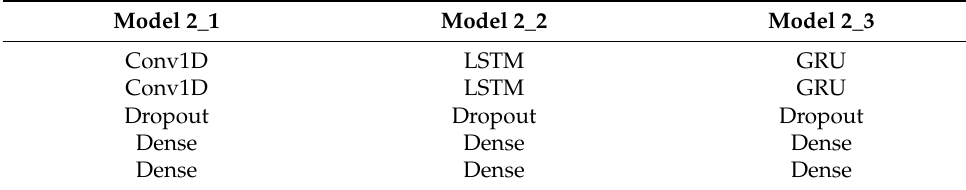
Table 2. Layers description for all models used in Experiment